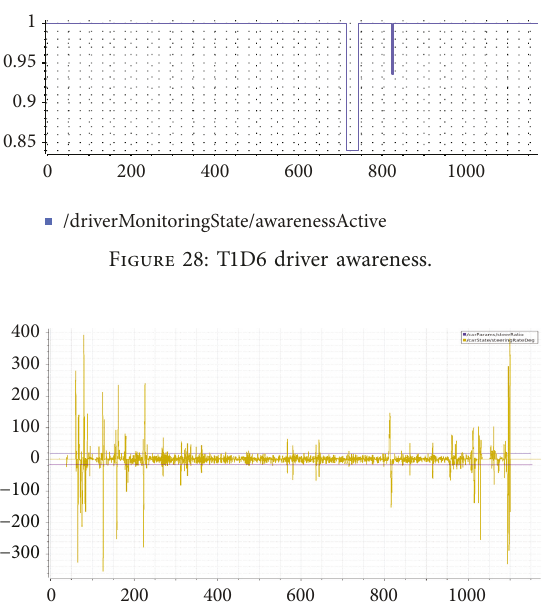
Figure 29: T1D6 steering degrees.